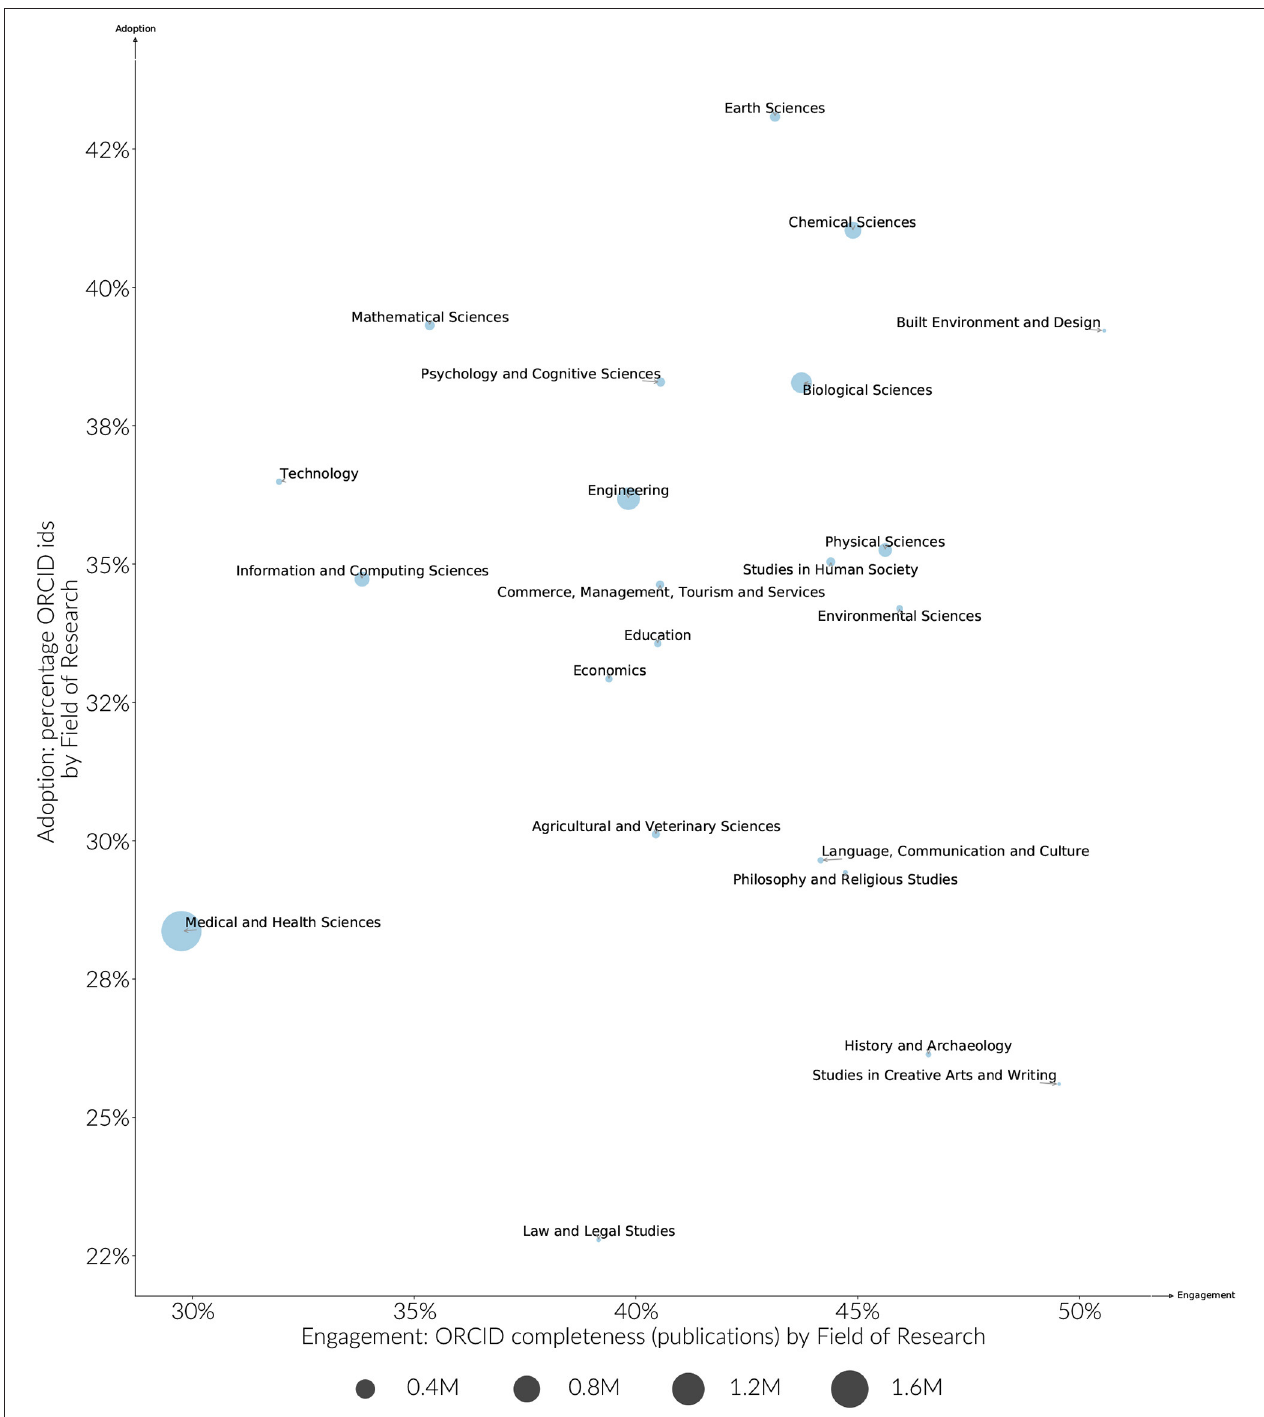
FIGURE 6 | Estimated ORCID adoption and engagement by Field of Research researchers > 5 years publication history, publications (2015–2019). The size of the circle represents the size of the identified research population.